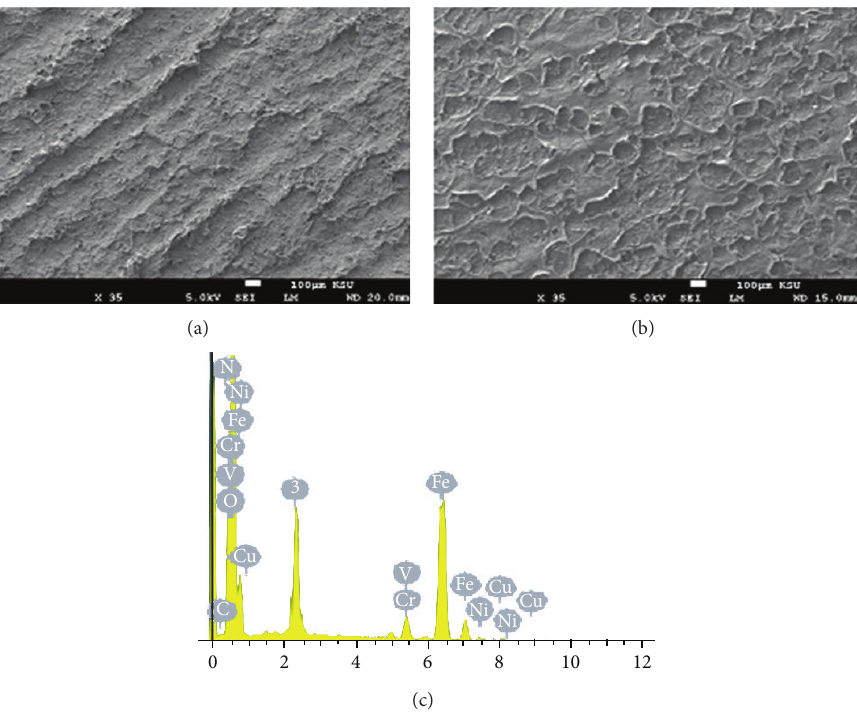
Figure 2: SEM micrographs obtained for the HSLA steel after 24 h immersion in 2.0 M H 2 SO 4 solutions, (a) without ATA and (b) with 5.0 mM ATA present, and (c) EDS profile analysis corresponding to the surface shown in Figure 2(b),